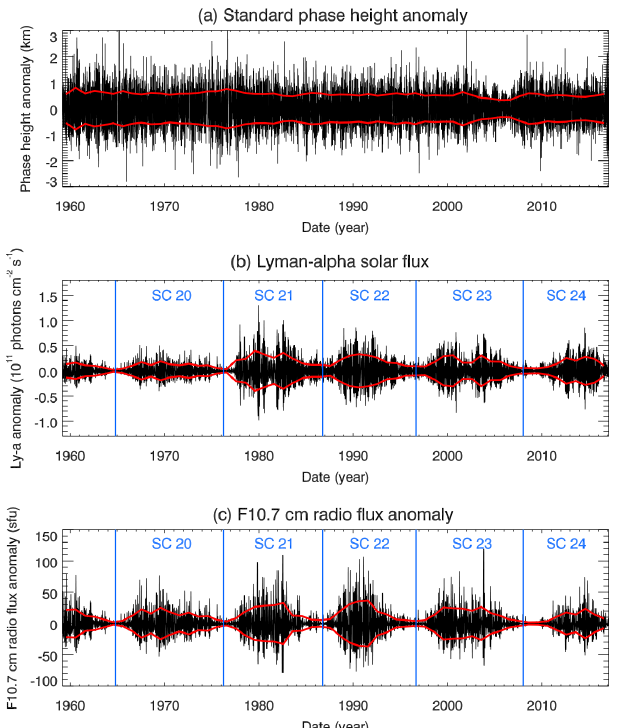
Figure 2. Anomaly time series of standard phase height (a) , solar Lyman- α flux (b) and F10.7cm solar flux (c) , determined by remov- ing a 41-day running mean from the time series shown in Fig. 1. The red lines correspond to 1 standard deviation determined in adjacent 100-day time bins.